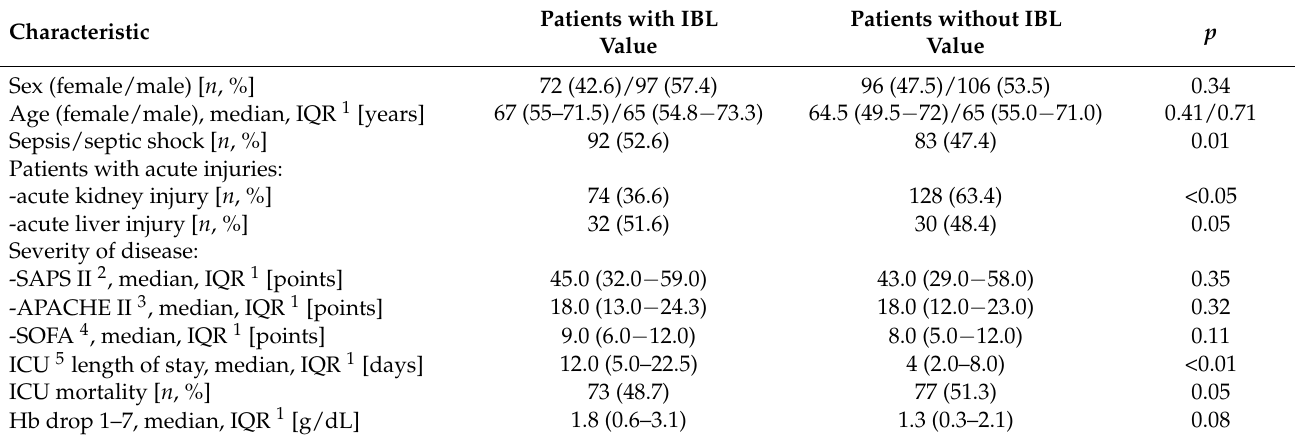
Table 6. Characteristics of patients with and without iatrogenic blood